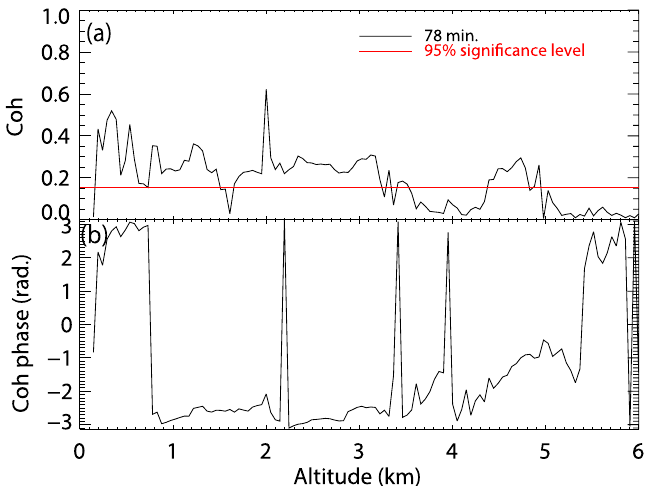
Figure 7. ( a ) Coherence of the main period (78.0 min) between the atmospheric electric fields at CHB and radar reflectivity of the FALCON-I for each height, and ( b ) the phase difference.